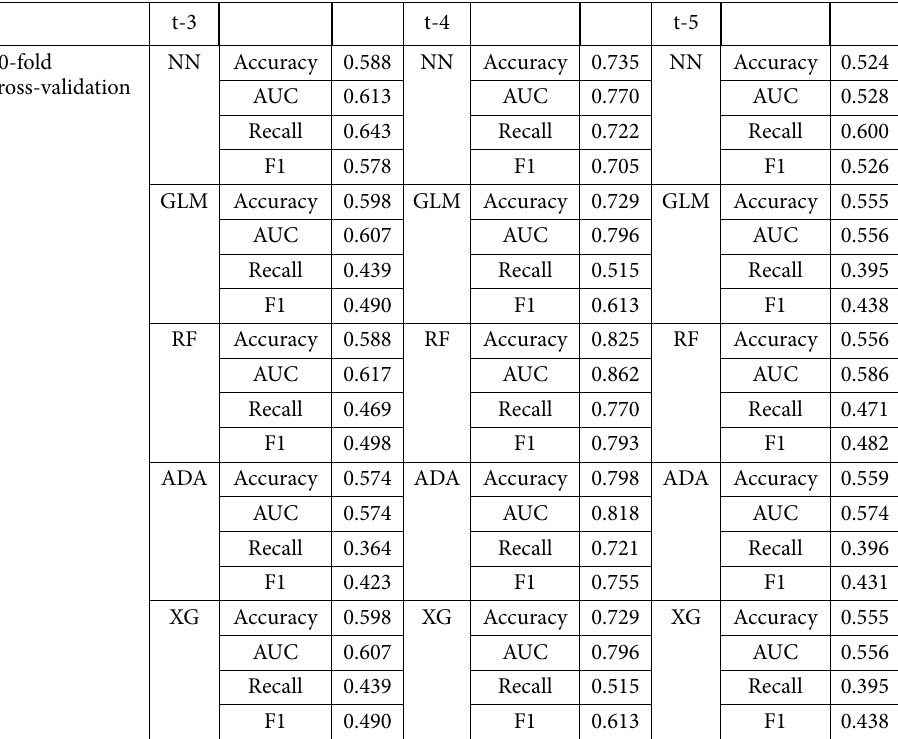
Table 8. Experimental results of different methods (Negative companies) t-3 t-4 t-5 10-fold cross-validation